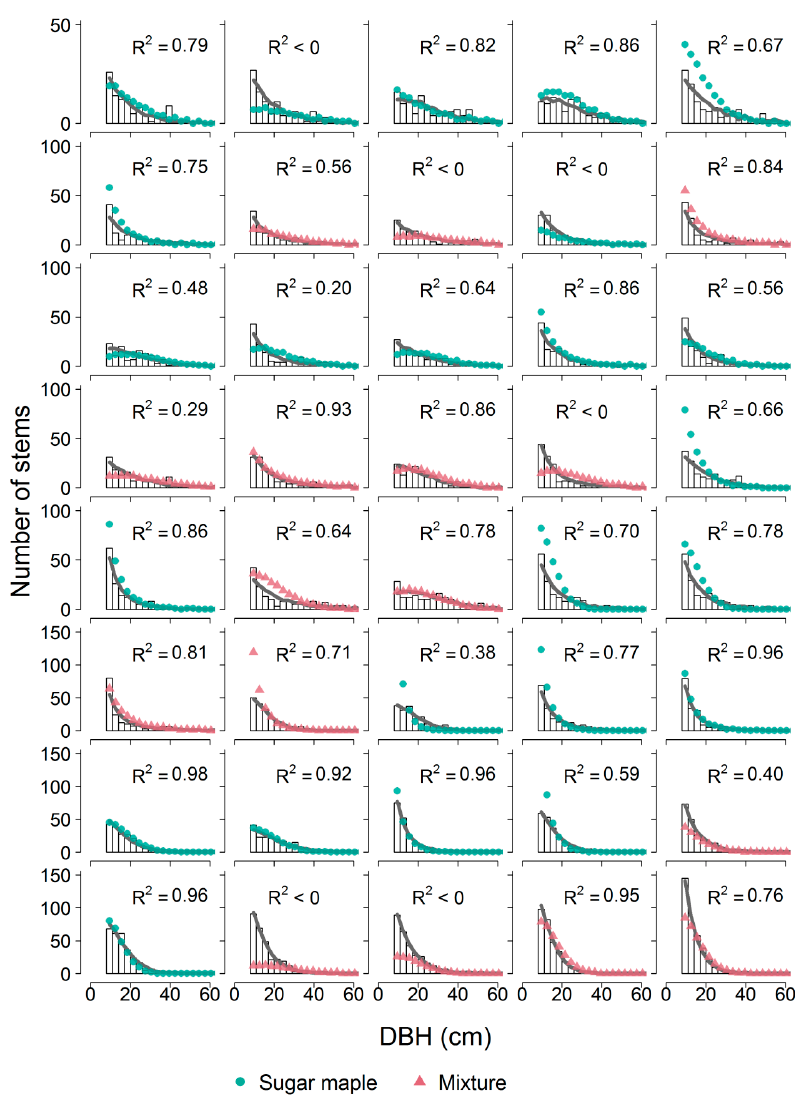
Figure 4. Stem diameter distributions for the 40 validation plots. Histograms show the measured stems, points show the predicted number of stems within each bin, and the solid line shows the Weibull distribution fitted to the data. The plots are ordered from low to high total stem numbers; note the changing y-axis.